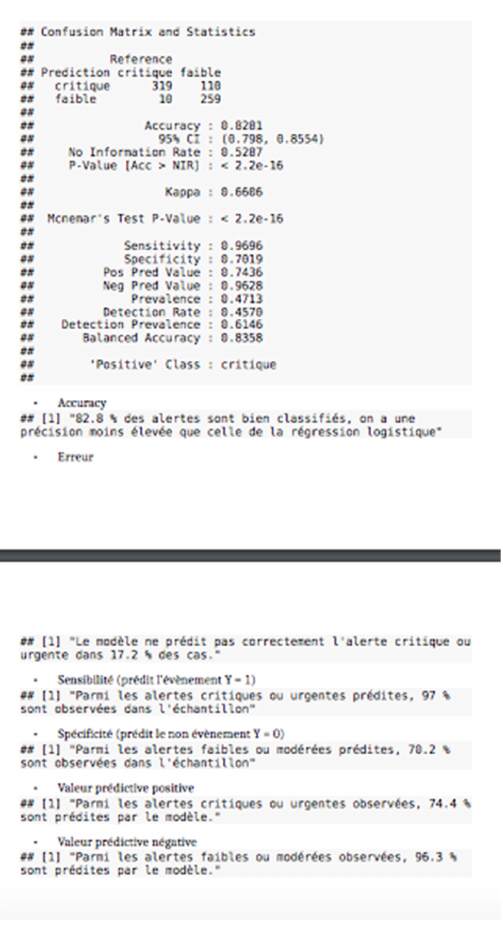
Figure 2. SVM model.